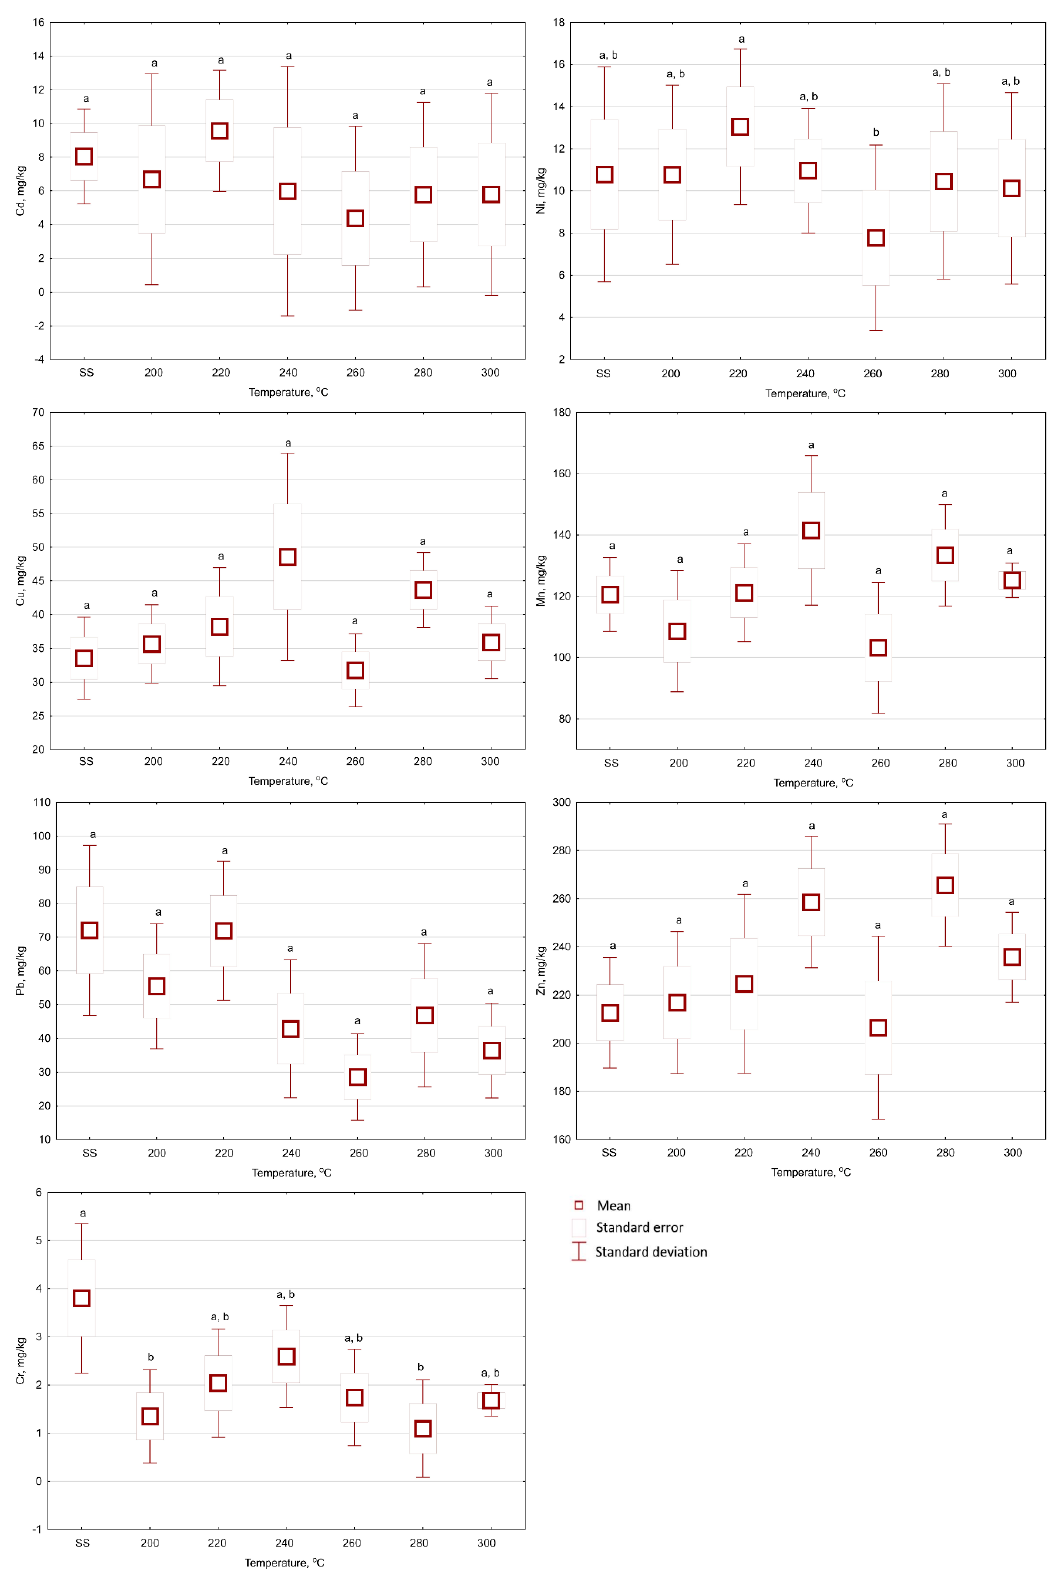
Figure 4. The influences of temperature on Cd, Ni, Cu, Mn, Pb, Zn, and Cr contents in biochars produced with 60 min of retention time under 200–300 °C temperatures (SS—raw sewage sludge). Letters indicate the statistically significant ( p < 0.05) differences between mean values.